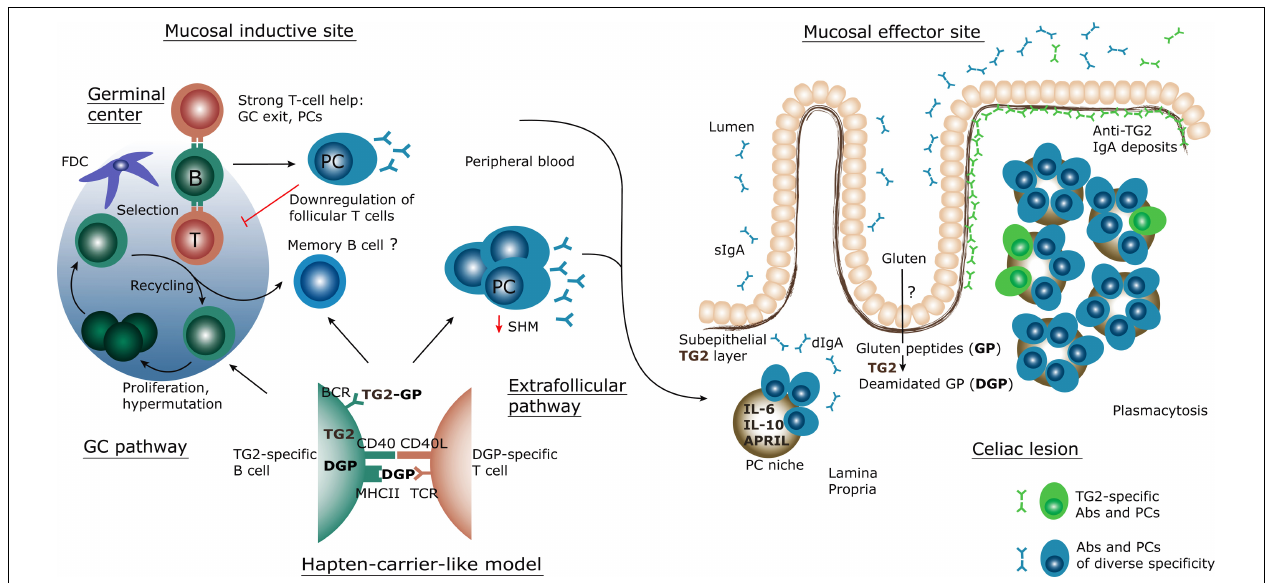
complexes.The B cell response generated follows either a canonical germinal center (GC) pathway or an extrafollicular pathway, resulting in massive plasmablast generation.The plasmablasts migrate via the blood to the lamina propria, where they mature as plasma cells (PC), secrete antibodies (Abs) and survive for extended time in what is called a PC survival niche. In active CD, this results in plasmacytosis and sustained secretion of IgA dimers (dIgA) – as well as IgM pentamers – which are transported across the epithelium to the lumen as secretory IgA (sIgA).TG2-specific antibodies produced at this site are also deposited on the subepithelial layer ofTG2. BCR, B cell receptor; FDC, follicular dendritic cell;TCR,T cell